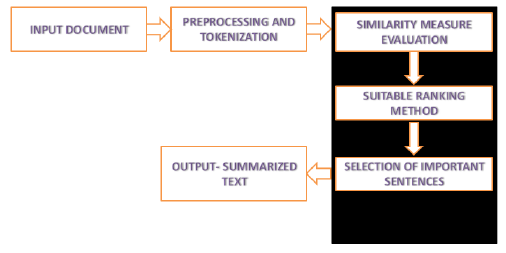
Figure 3. Loss graph for abstractive summarization